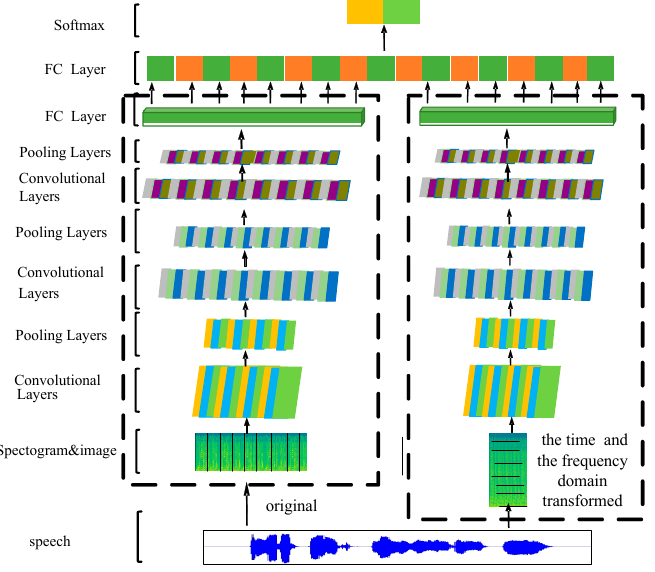
Figure 1. Double-channel model structure based on convolutional neural network (CNN).